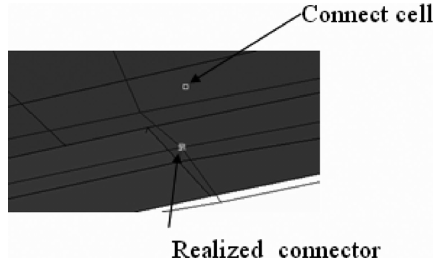
Fig. 4. Connector realized.